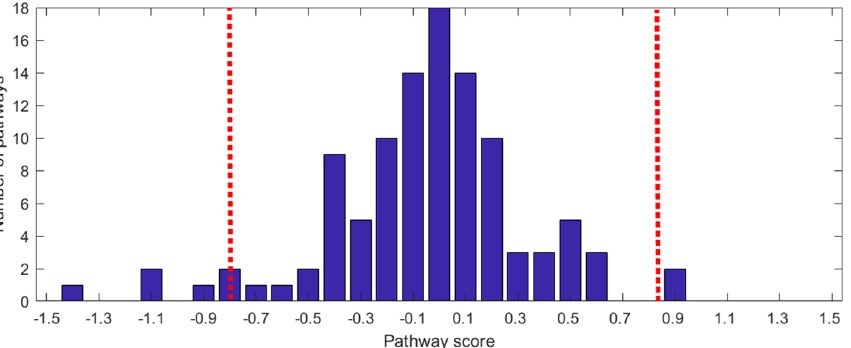
Figure 4. Pathway score distribution. The histogram of observed pathway scores is shown. The score thresholds for determining outliers according to median absolute deviation (MAD) is also marked (red dashed lines, three scaled median deviations away from the